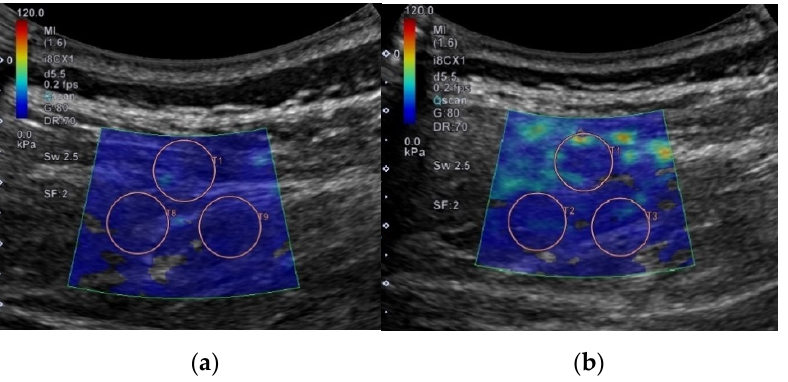
Figure 3. Example for setting regions of interest to measure shear elastic modulus in different postures on flat and Wilson table. In this case, erector spinae 1 located at L3–4 is shown: ( a ) flat table; ( b ) Wilson table.